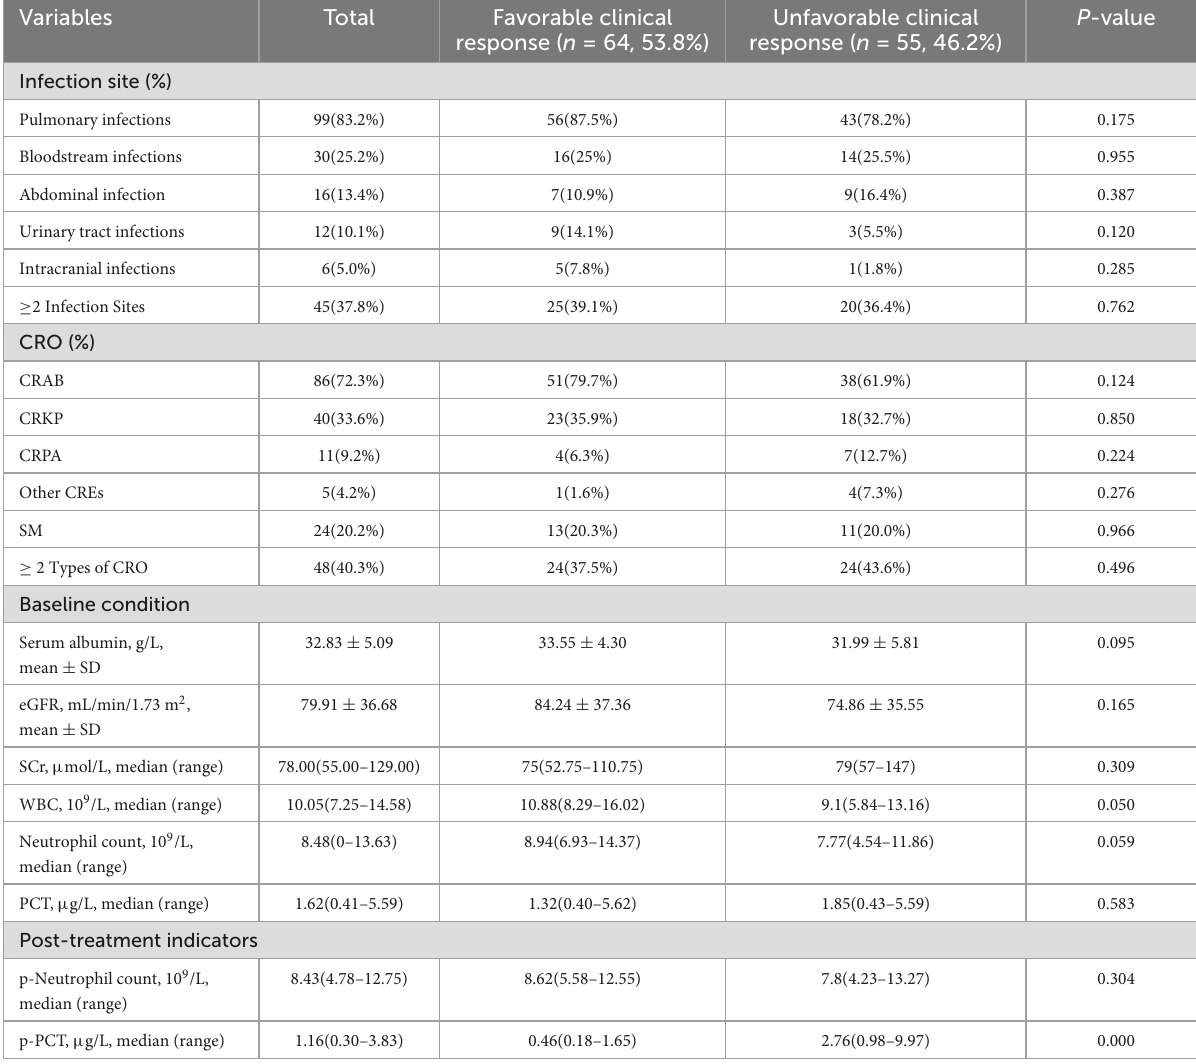
TABLE 2 The clinical characteristics of CRO infections in 119 patients receiving polymyxin E sulfate based on different clinical responses.